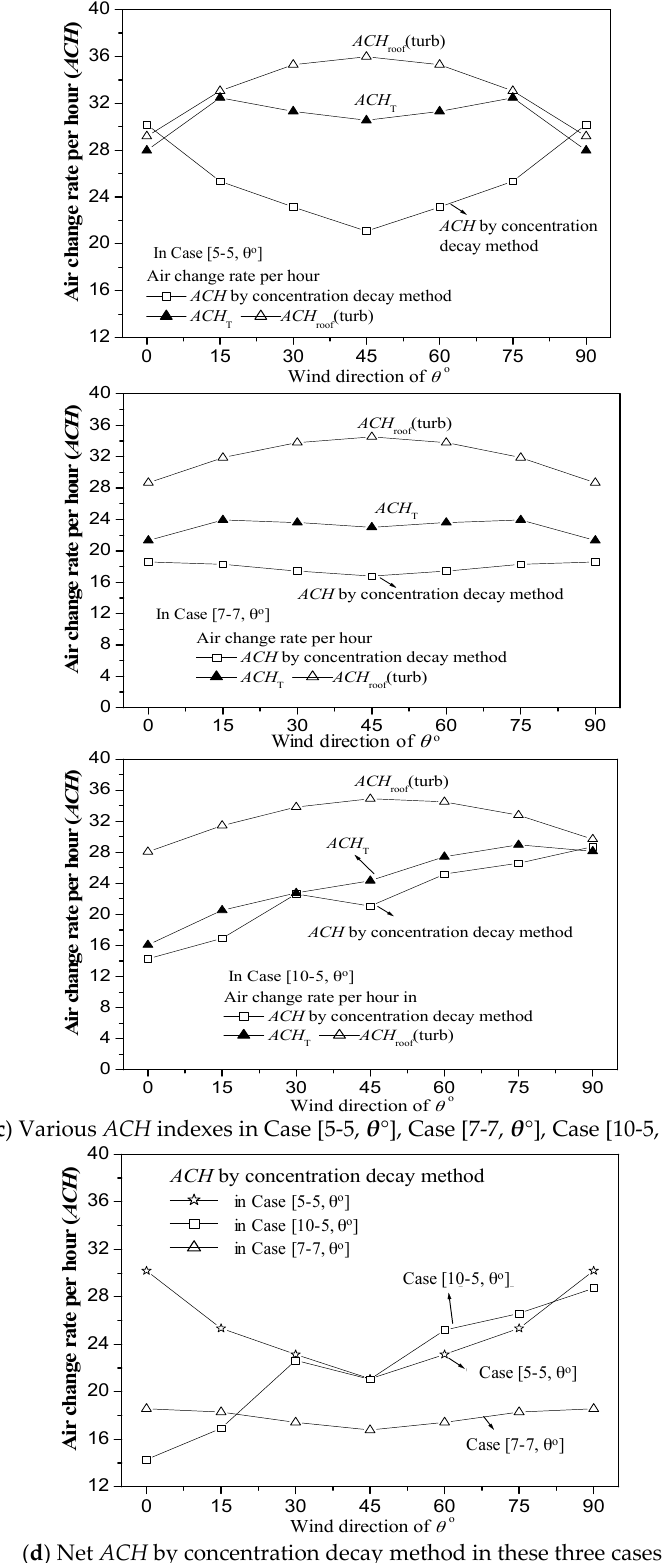
Figure 7. Normalized velocity in ( a ) Case [7-7, θ ° ]; ( b ) case [10-5, θ ° ]; ( c ) Various ACH indexes in Case [5-5, θ ° ], Case [7-7, θ ° ], Case [10-5, θ ° ]; ( d ) Net ACH by concentration decay method in these three cases.